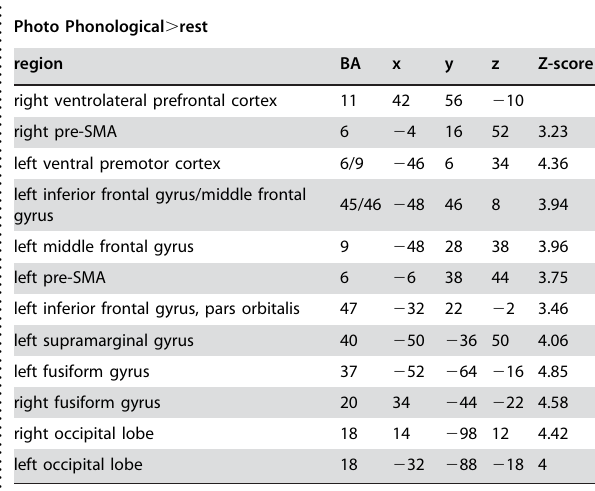
Table 1. Peak voxel coordinates in MNI space and z-values for the fMRI contrasts revealing the action observation network. .. ... .... ... ... .... ... ... .... ... ... .... ... ... .... ... ... .... ... ... .... . Video Perception . rest